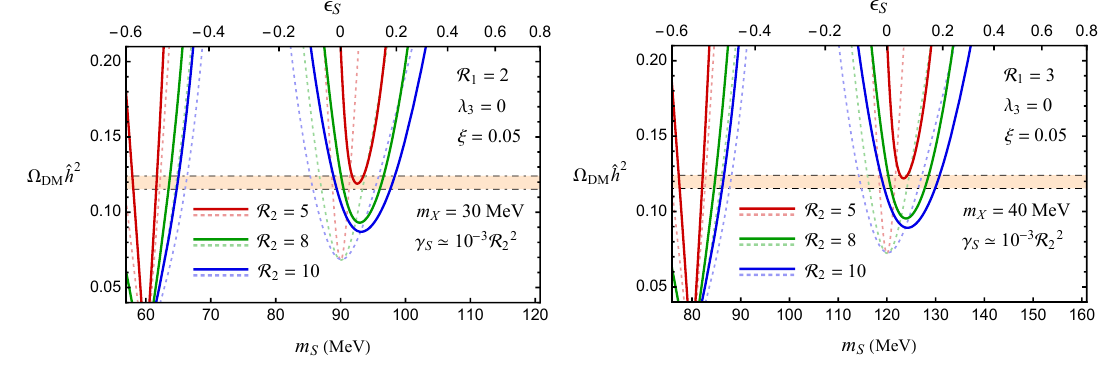
Figure 4 . The predicted relic density versus m S for nonzero (zero) temperature of DM in solid lines (light dashed lines). The orange band is the observed value 0 : 1153 (cid:20) (cid:10) DM ^ h 2 (cid:20) 0 : 1241 at the 95%